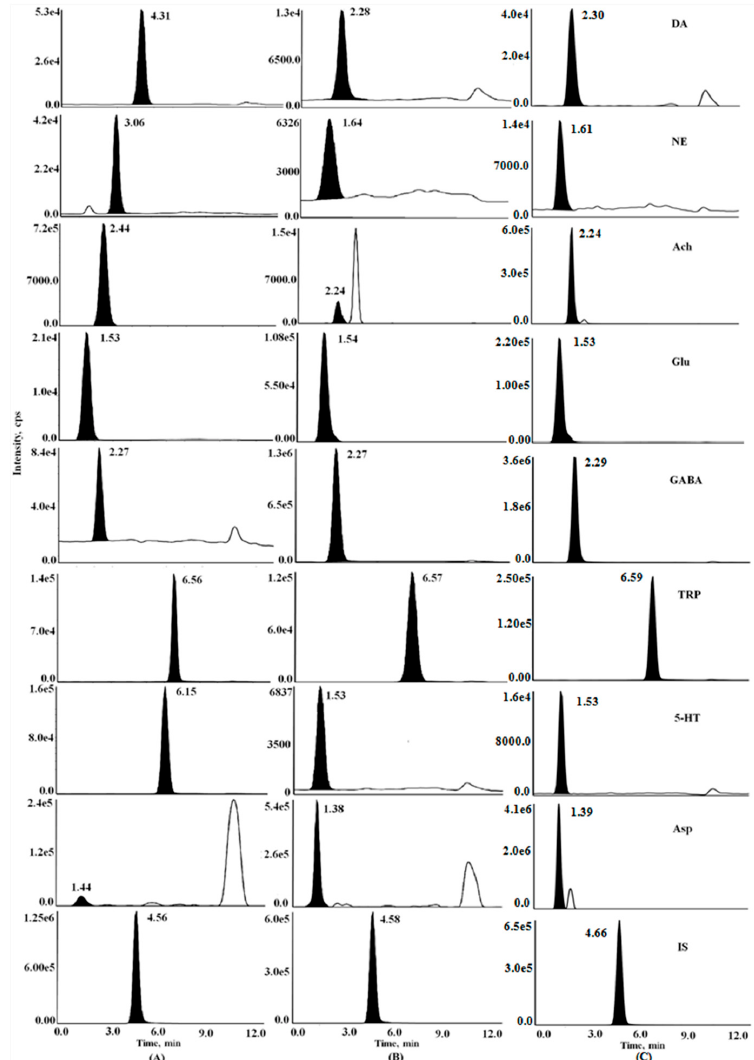
Figure 1. Typical multiple reaction monitoring chromatograms of eight standards and internal standard ( A ), the brain samples of the AD rats ( B ) and a blank sample spiked analytes and IS ( C ). DA, Dopamine; NE, norepinephrine; 5-HT, 5-hydroxytryptamine; Ach, acetyl choline; Trp, L -tryptophan; GABA, γ -aminobutyric acid; Glu, glutamic acid; Asp, aspartic acid.